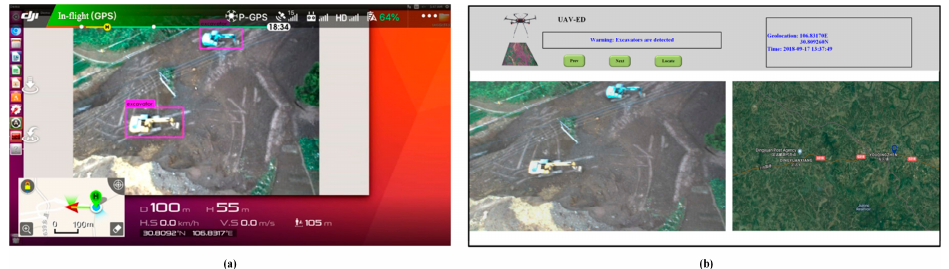
Figure 10. Interfaces of the UAV Control Module and the Warning Module. ( a ) The UAV Control Module is able to display the real-time video processed by the UAV module; ( b ) the Warning Module is able to display the detection results (i.e., the images of the detected excavators, the latitudes / longitudes, and time) of the UAV-ED system.